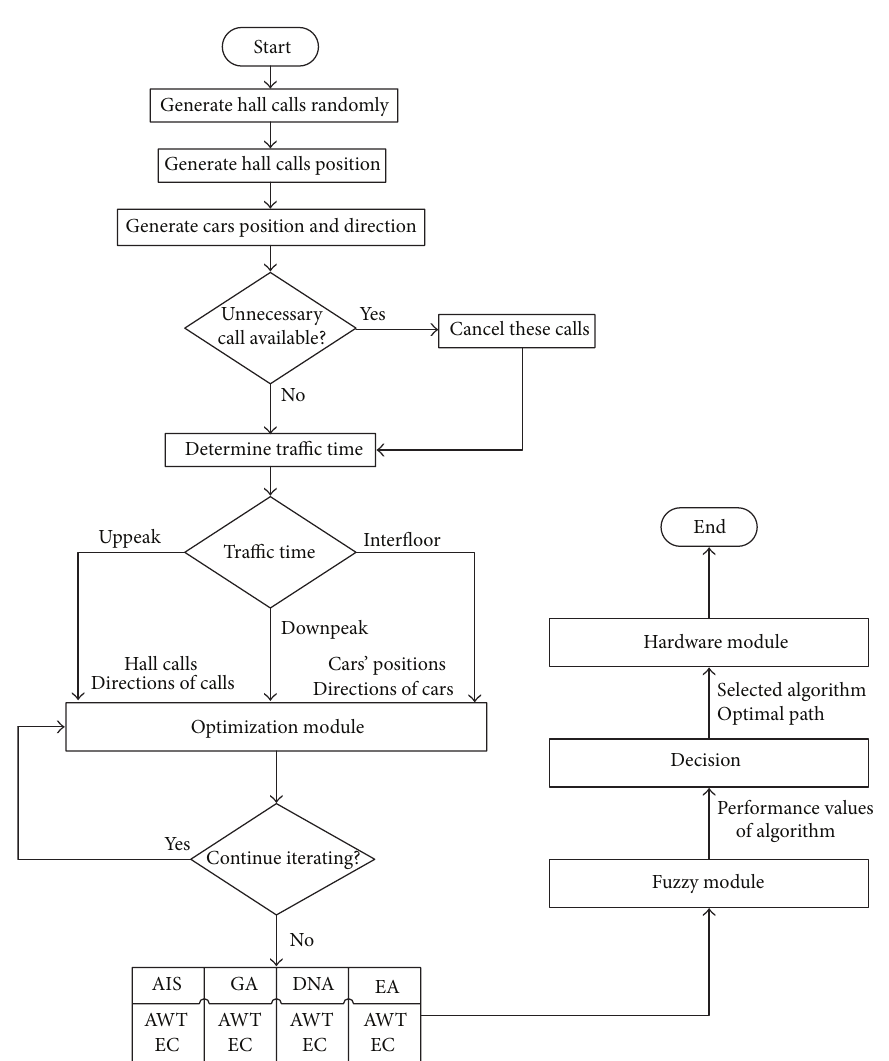
Figure 2: Flow chart of the proposed